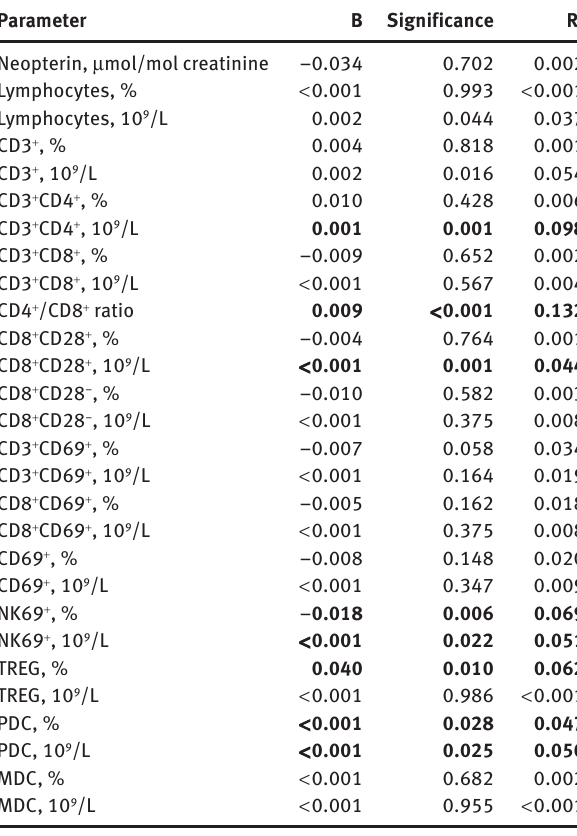
Table 4: Linear regression analysis of changes in patients treated for metastatic disease (cohort